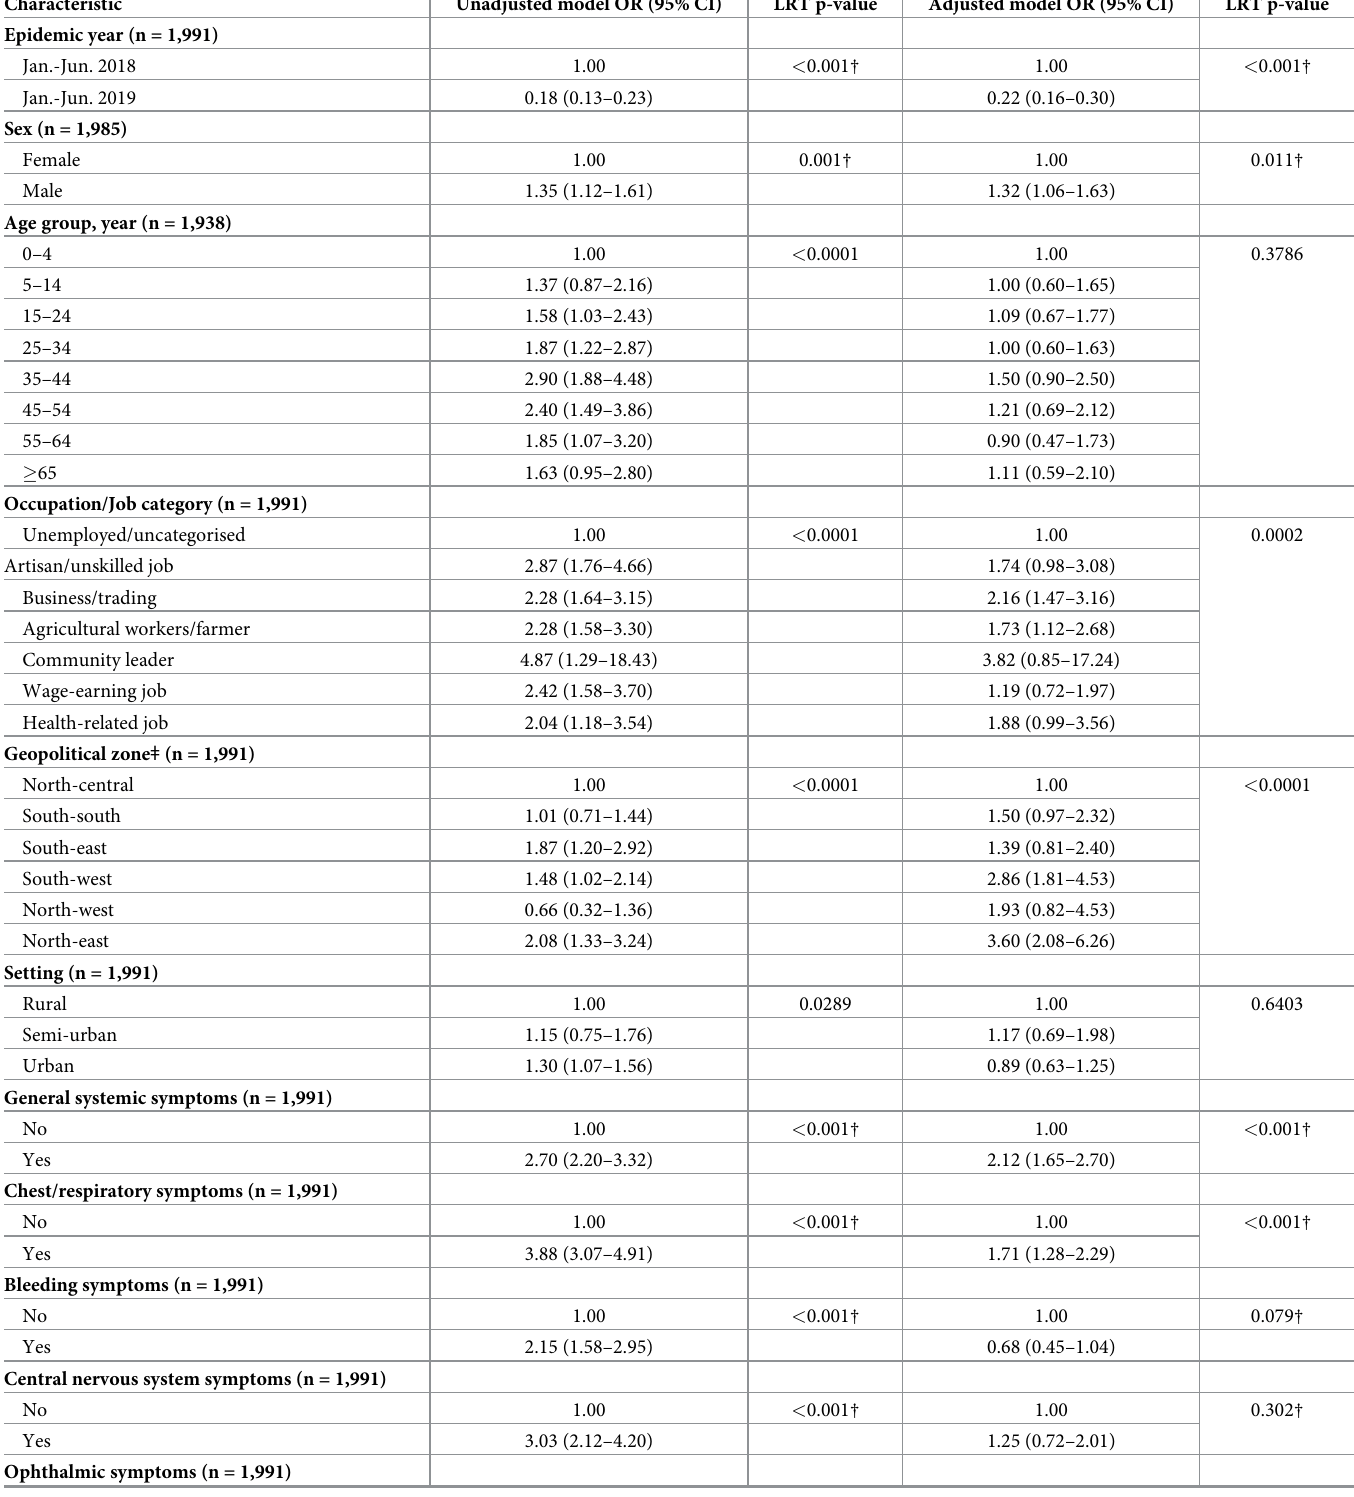
Table 4. Logistic regression: Socio-demographic & clinical predictors of Lassa